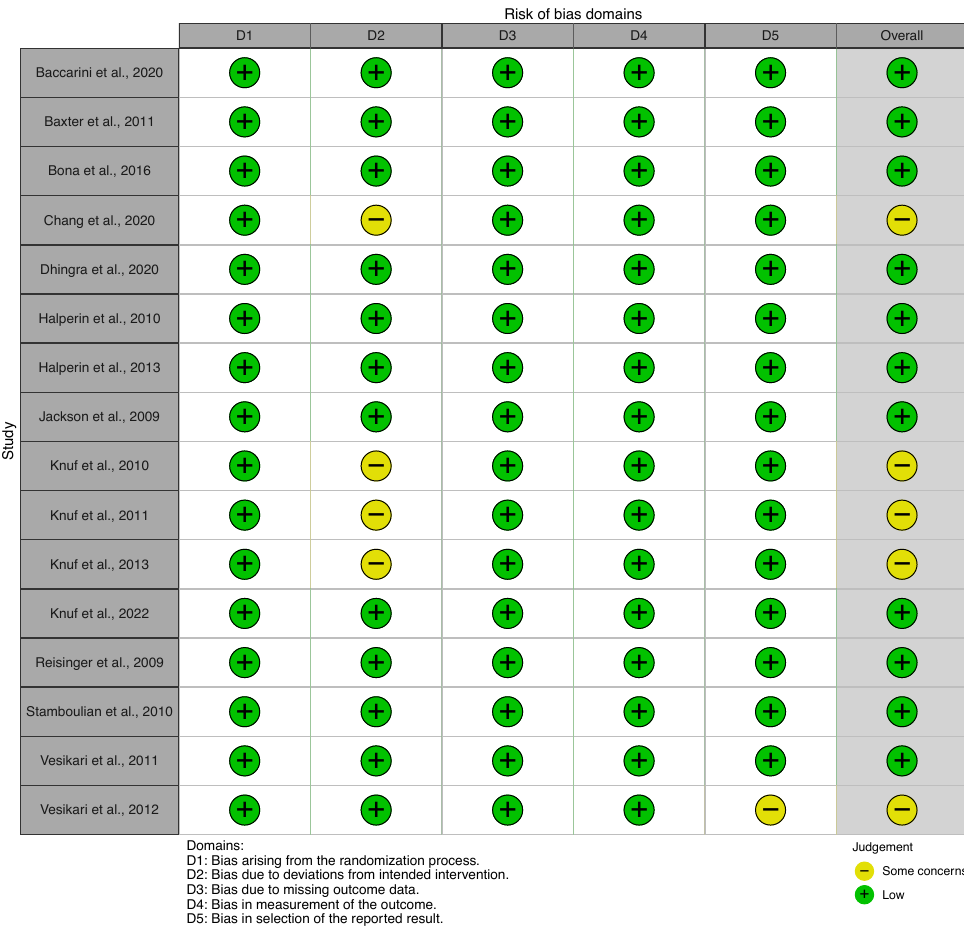
D5: Bias in selection of the reported result.